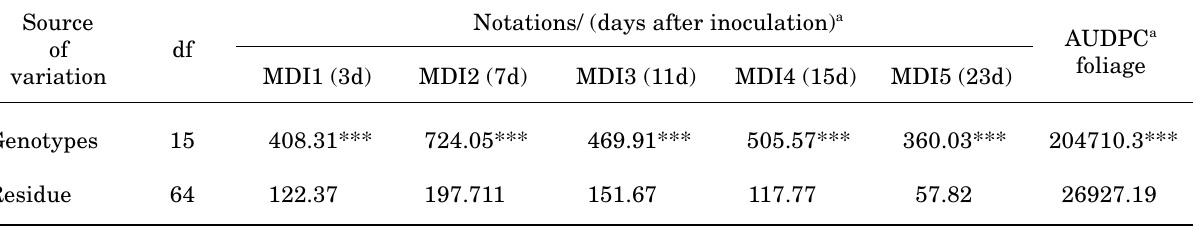
Table 3. ANOVA of mass disease indexes 3 to 23 days after inoculation (MDI1–MDI5) and of area under disease progress curves (AUDPC) (for foliage infection) under greenhouse